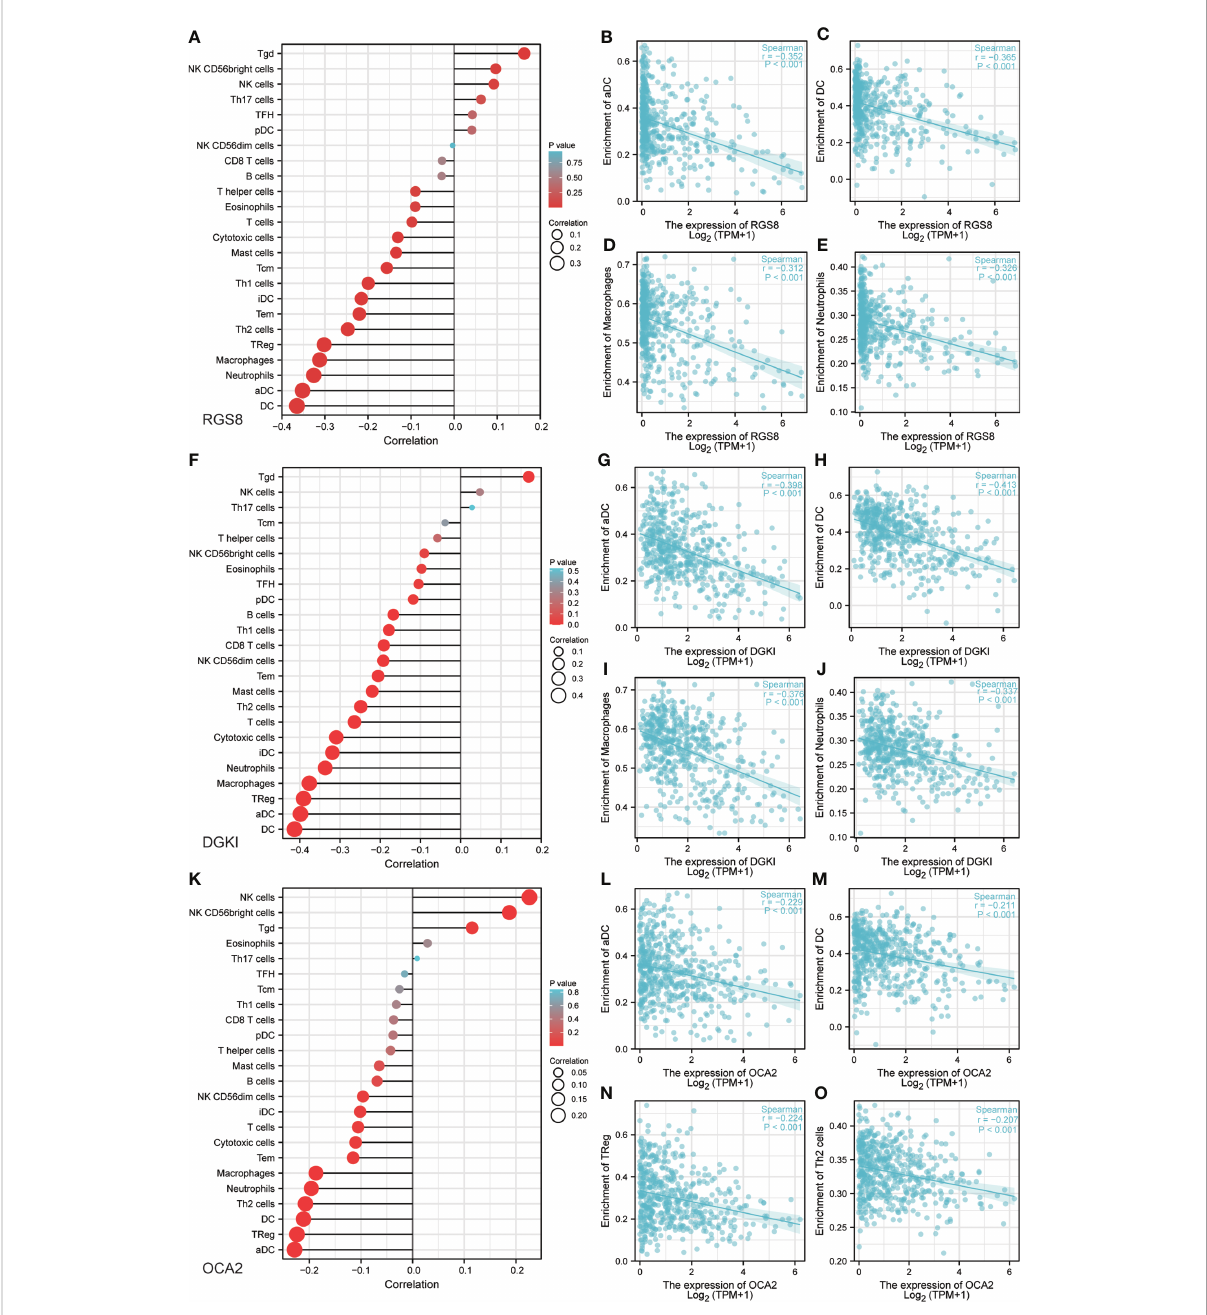
FIGURE 6 Correlation between RGS8, DGKI, OCA2 expression and immune characteristics. Association between the RGS8 (A) , DGKI (F) , OCA2 (K) expression level and relative abundances of 24 immune cells. Scatter plot of RGS8 (B – E) , DGKI (G – J) , OCA2 (L – O) expression and individual immune cell in fi ltration